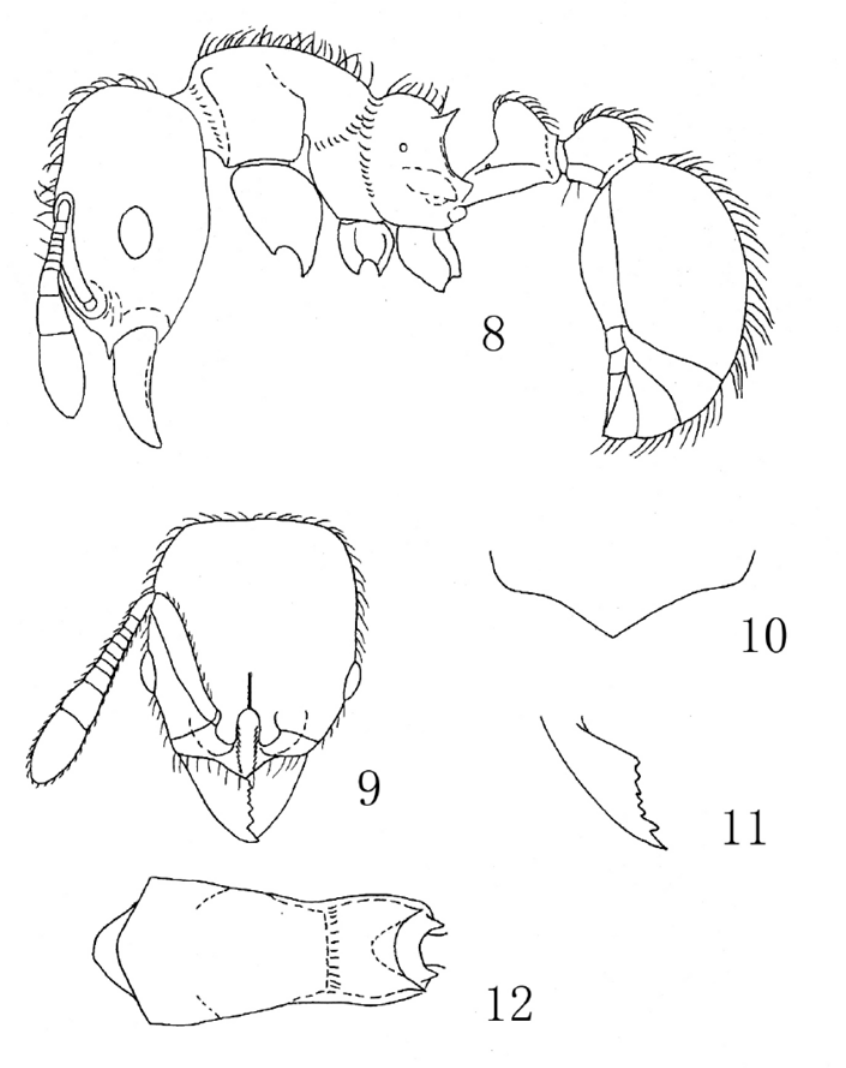
Figs. 8-12:Worker of Lasiomyrma gedensis Terayama & Yamane; 8. Head and body in profile view; 9. Head in full face view; 10. Anterior clypeal margin in dorsal view; 11. Mandible in dorsal view; 12. Alitrunk in dorsal view. (Cited from Terayama & Yamane